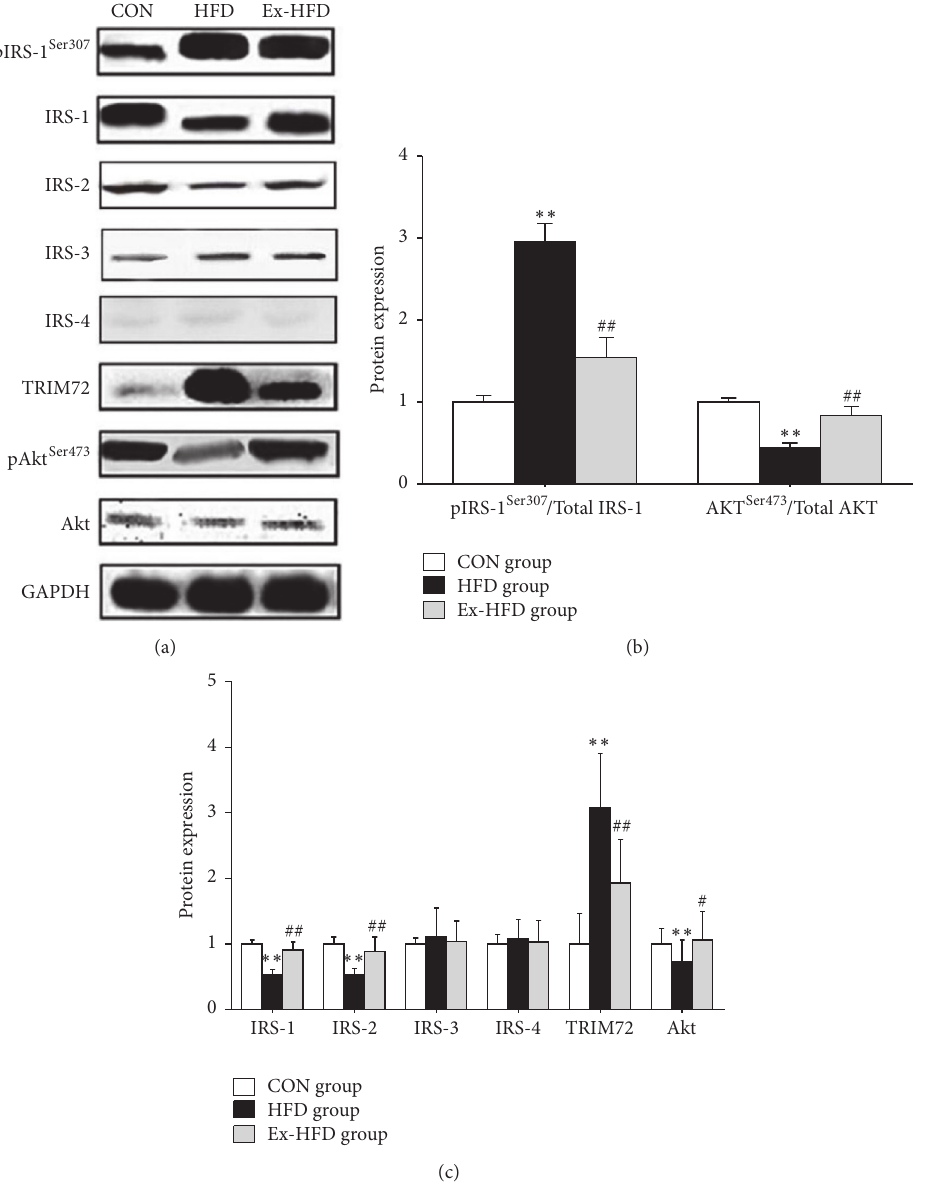
Figure 4: Protein expression of TRIM72, IRS-1, IRS-2, IRS-3, and IRS-4 and phosphorylation of IRS-1 (Ser307) and AKT (Ser473) levels in skeletal muscle were tested by western blot. ∗∗ 𝑝 < 0.01 : versus CON group; ∗ 𝑝 < 0.05 : versus CON group; ## 𝑝 < 0.01 : versus group HFD group; and # 𝑝 < 0.05 : versus group HFD